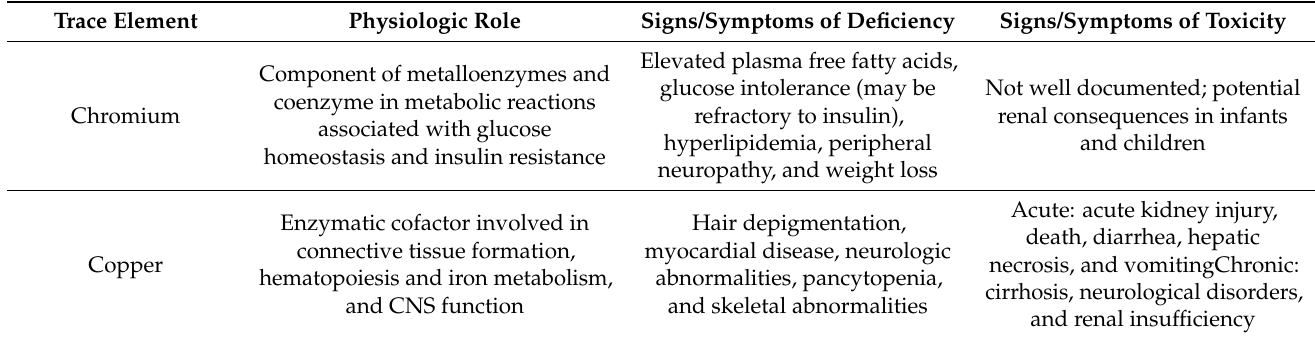
Table 1. Physiologic properties of TEs that are routinely included in PN